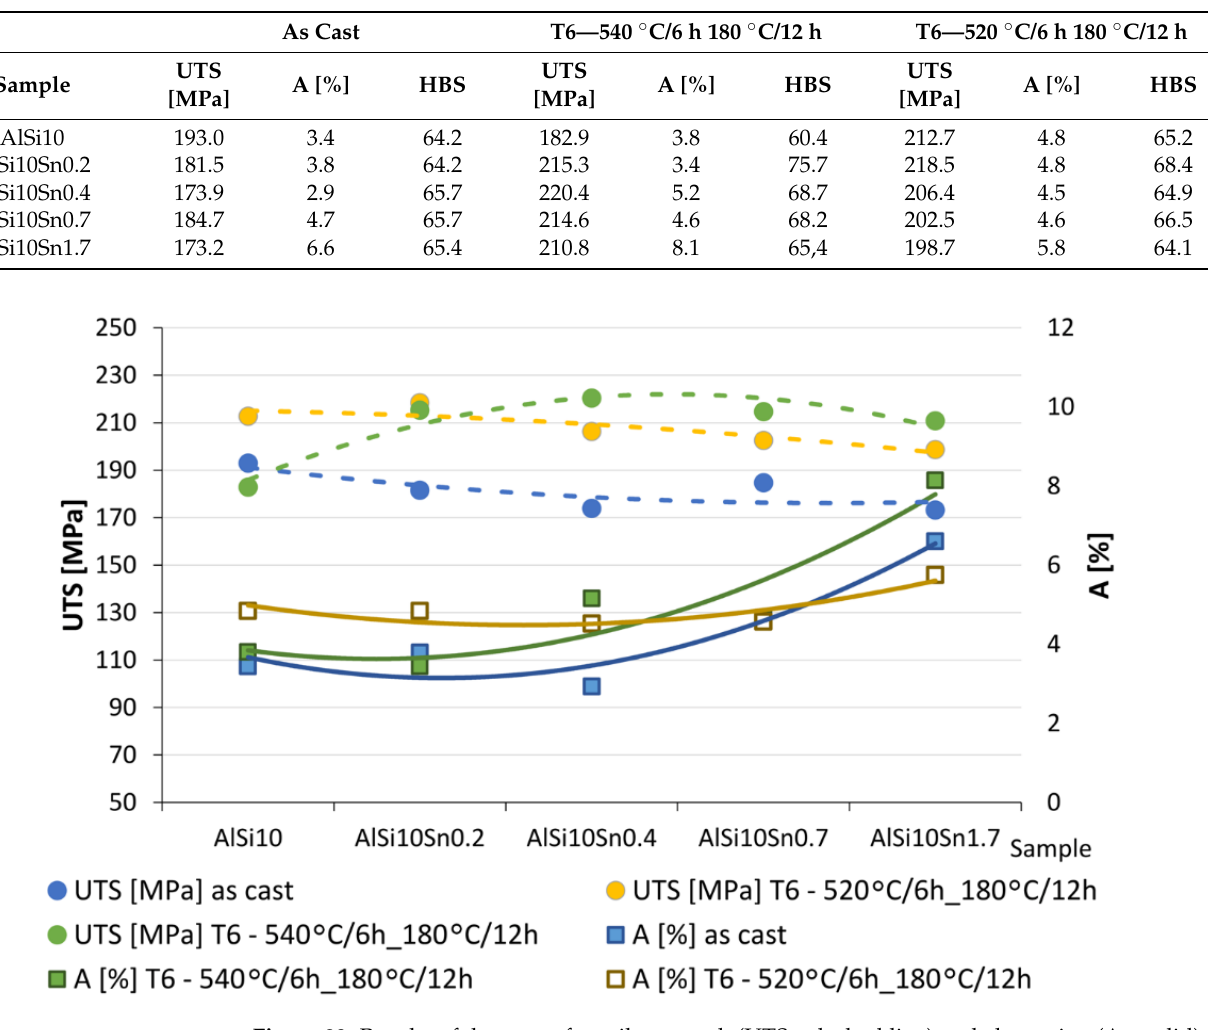
Figure 23. Results of the tests of tensile strength (UTS—dashed line) and elongation (A—solid) for AlSi10 alloys with variable tin additions. Blue line—as cast; green line—T6—540 ◦ C/6 h_180 ◦ C/12 h; yellow line—T6—520 ◦ C/6 h_180 ◦ C/12 h.